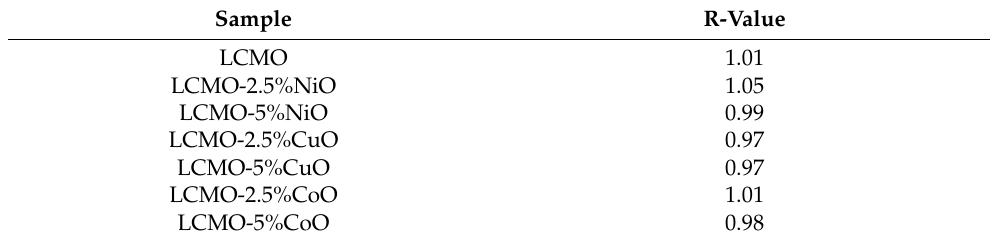
Table 8. R-value for LCMO-MO composite